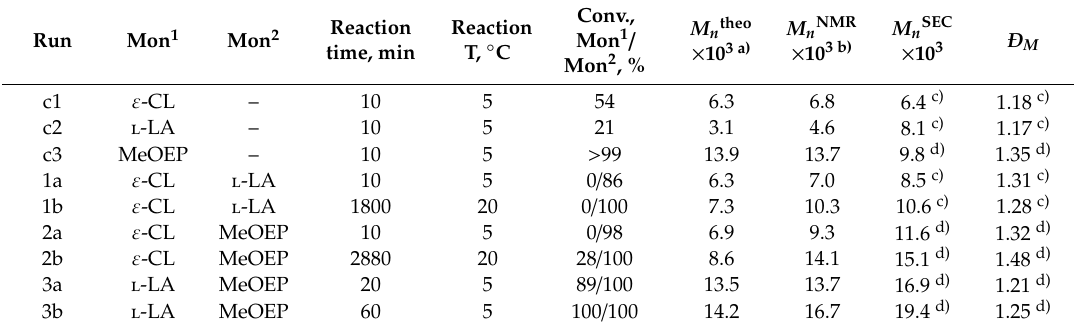
Table 3. Polymerization experimental data for BHT-Mg catalyzed copolymerization in ε -CL / l -LA, ε -CL / MeOEP and l -LA / MeOEP mixtures. Reaction